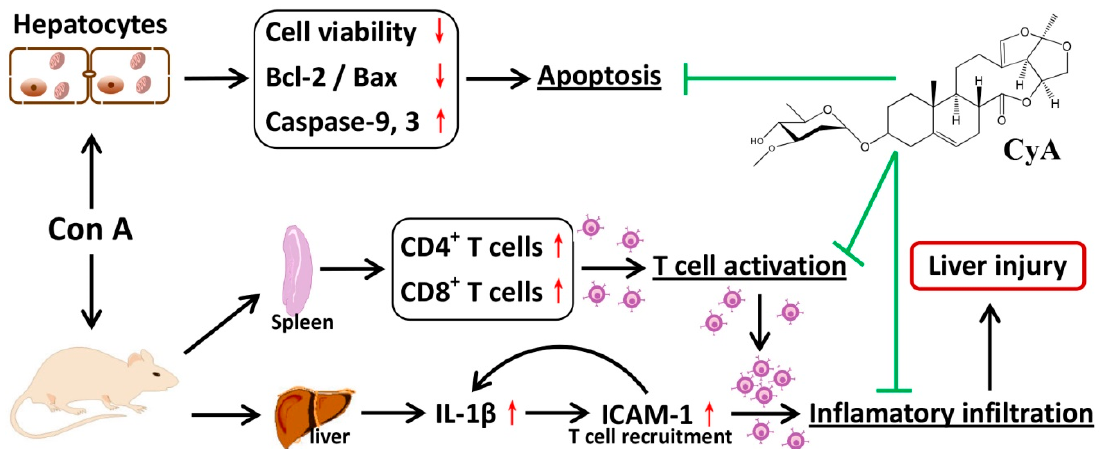
Figure 6. Chemical structure of CyA and a sketch of its effects on Con A-induced liver and hepatocyte injury.